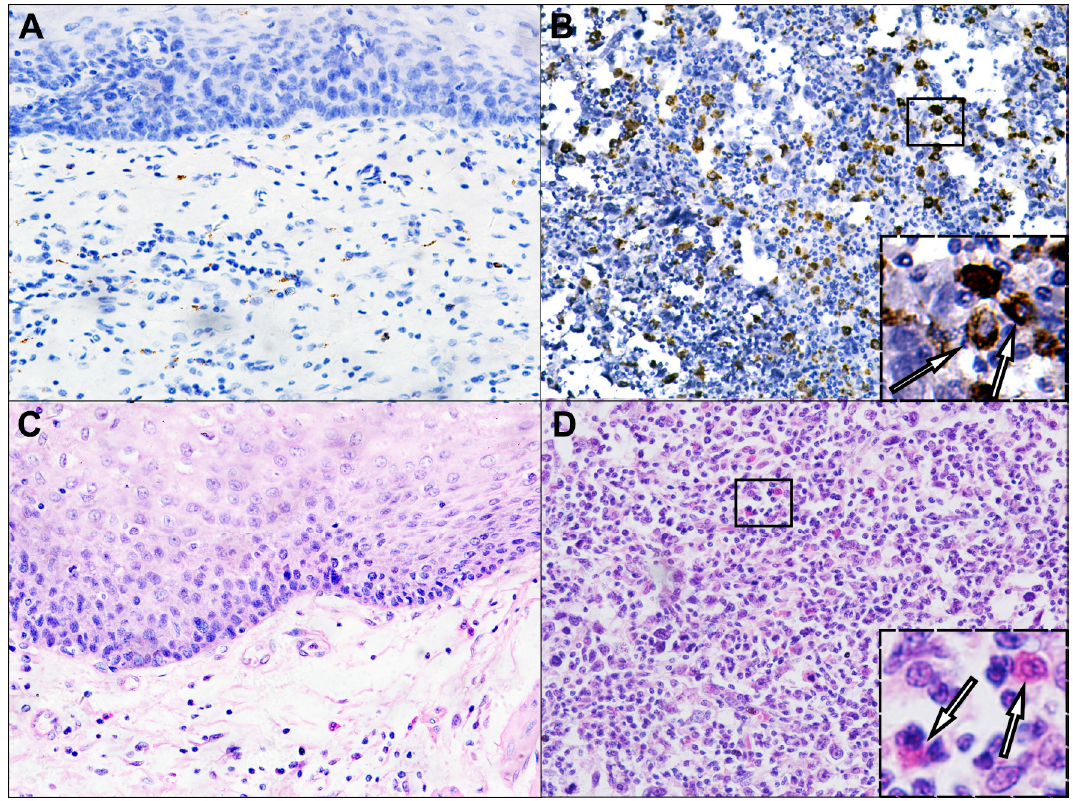
Figure 1. Infiltration of macrophages and eosinophils into the SmCEC tissues and tumor adjacent normal tissues. ( A ) Macrophages in tumor adjacent normal tissue; ( B ) Macrophages in SmCEC; ( C ) Eosinophils in tumor adjacent normal tissue; and ( D ) Eosinophils in SmCEC. (Original magnification 200×) Insets: higher magnifications of macrophages and eosinophils (Original magnification